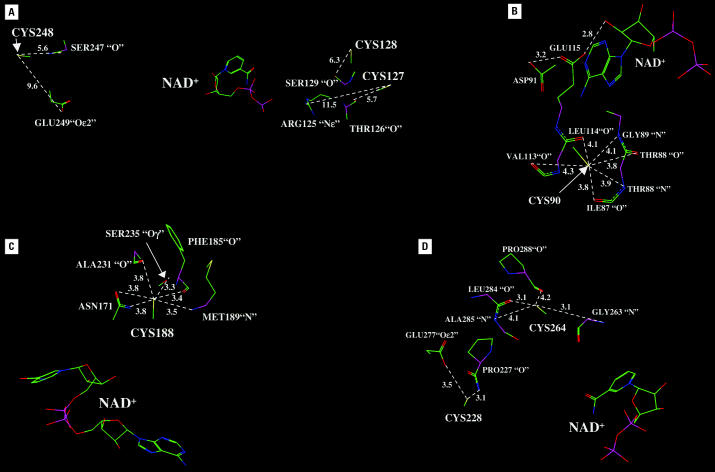
Predicted interactions of cysteine residues in the conserved core domain of 11β-HSD2. ( A) Cys127, Cys128, and Cys248 are oriented into the solvent, away from the catalytic pocket, and have few stabilizing interactions with other residues. ( B) Cys90 interacts with amino acids that stabilize Glu115 and Asp91, which have a critical role by forming hydrogen bonds to the ribose hydroxyl on NAD+ that are important to stabilize binding of the cofactor and maintain its orientation to the substrate. ( C) Cys188 is not directly involved in interactions with NAD+ but stabilizes several amino acids that interact with the pyrophosphate segment of the cofactor. ( D) The thiol on Cys228 stabilizes the position of Pro227 and Glu277, which are important for positioning of the catalytic tyrosine and the nicotinamide ring and for binding of the steroid substrate. The thiol group of Cys264 has important interactions with Leu284, Ala285, and Pro288 in the helix in the C-terminal region of 11β-HSD2, which is important for substrate binding. Predicted interatomic distances in angstroms are depicted by number. Blue: nitrogen; green: carbon; purple: phosphorus; red: oxygen; and yellow: sulfur.